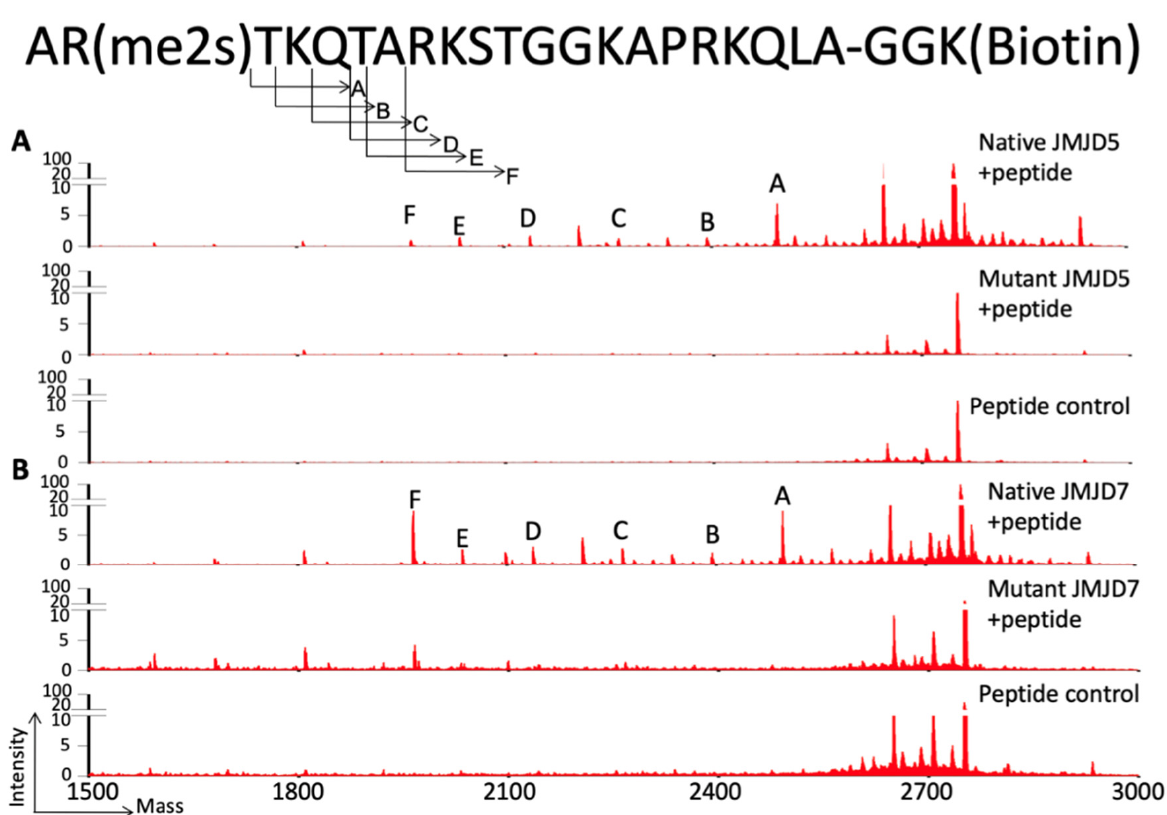
Figure 9. The endopeptidase and carboxy-exopeptidase activities of c-JMJD5 and c-JMJD7 on synthe- sized histone tails. ( A ). c-JMJD5 and mutant c-JMJD5 cleavage on H3R2me2s. The top portion is the sequence of the H3R2me2s peptide with symmetric di-methylation on R2 with MW 2749.47 Da. After cleavage, a major band of MW 2494.3 (peak A) is the product of peptide with the first two residues missing. ( B ). c-JMJD7 generated a similar profile [23].